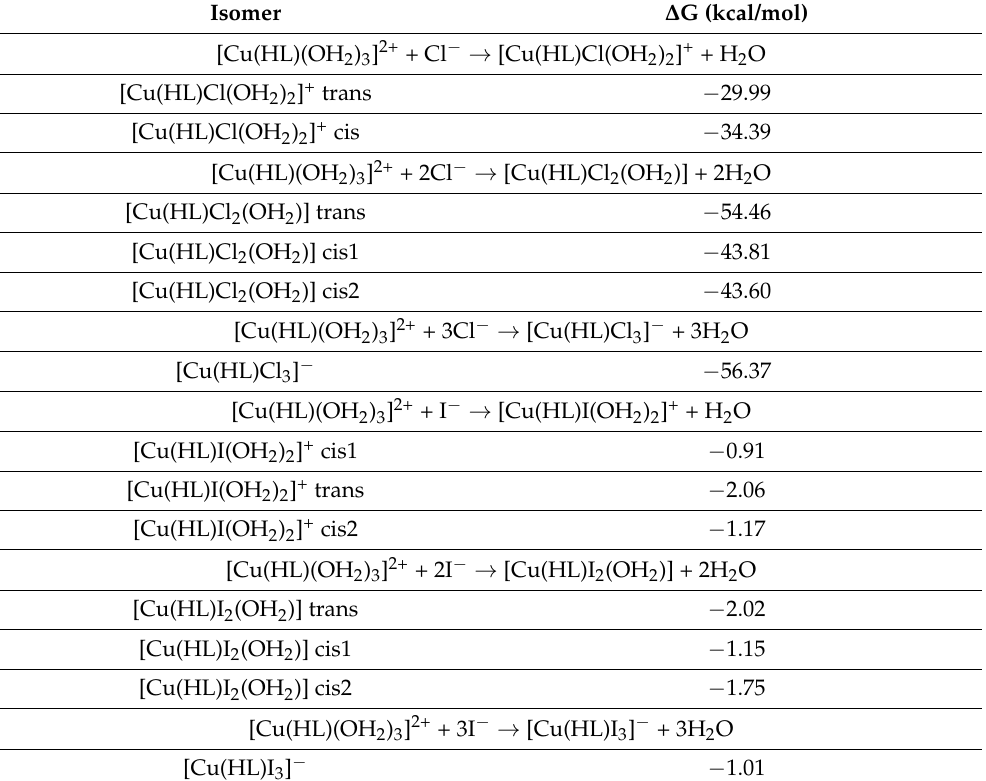
Table 3. Free energy of the reactions for the successive substitution of aqua ligands with iodide or chloride in [Cu(HL)(OH 2 ) 3 ] 2+